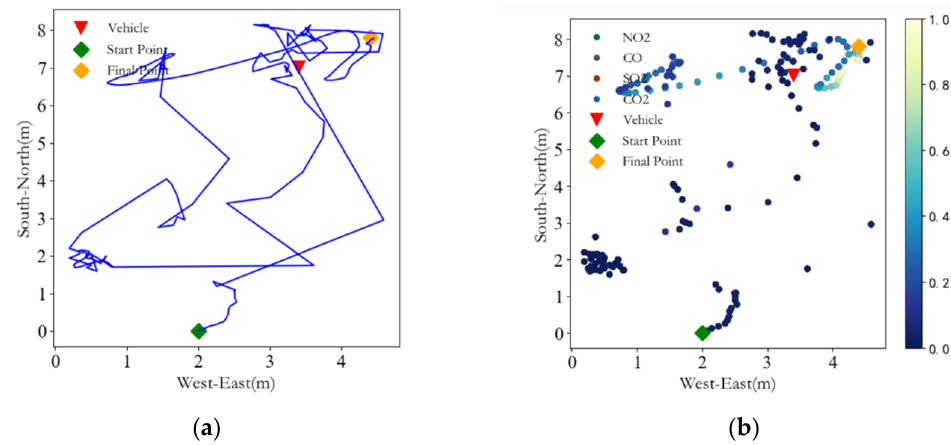
Figure 23. ( a ) Flight trajectory; ( b ) The changes in various gas concentrations.